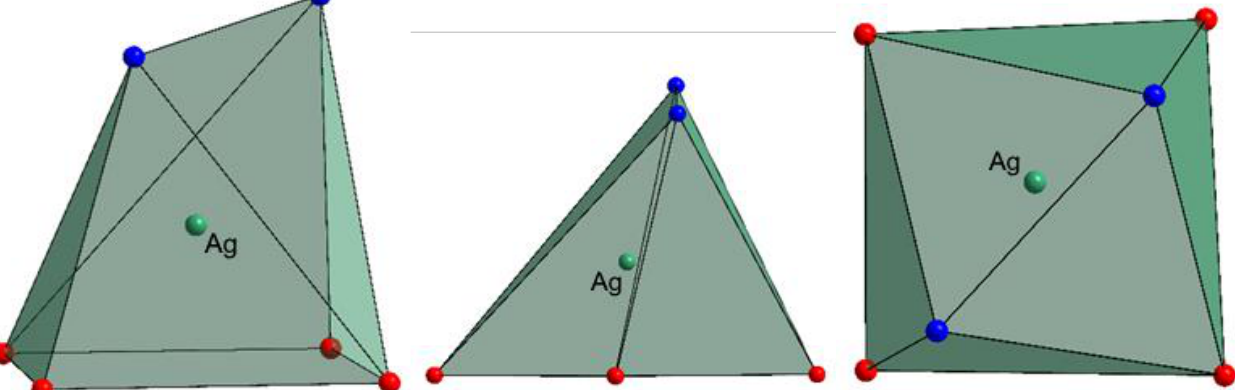
Figure 3. The coordination polyhedron of Ag + . O-atoms are red, N-atoms are blue.